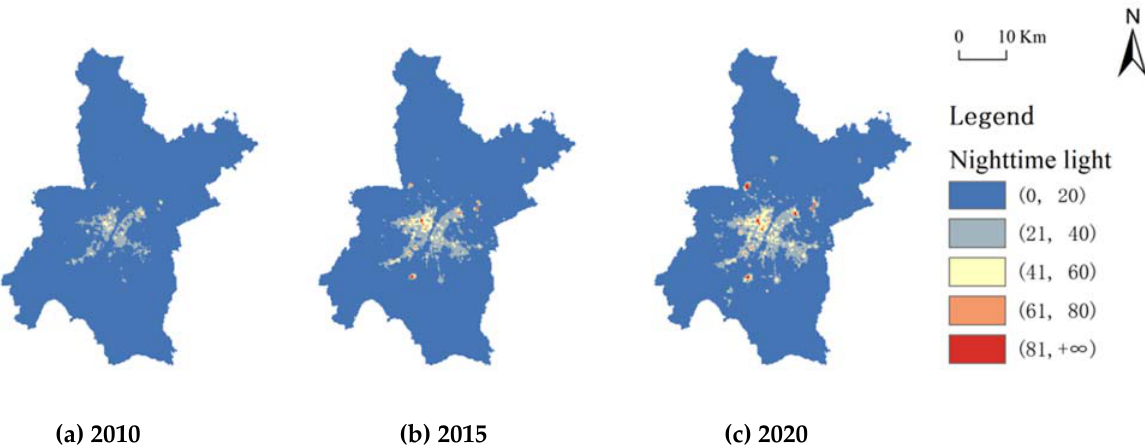
Figure 3. Nighttime light of Wuhan City in ( a ) 2010, ( b ) 2015, and ( c ) 2020.